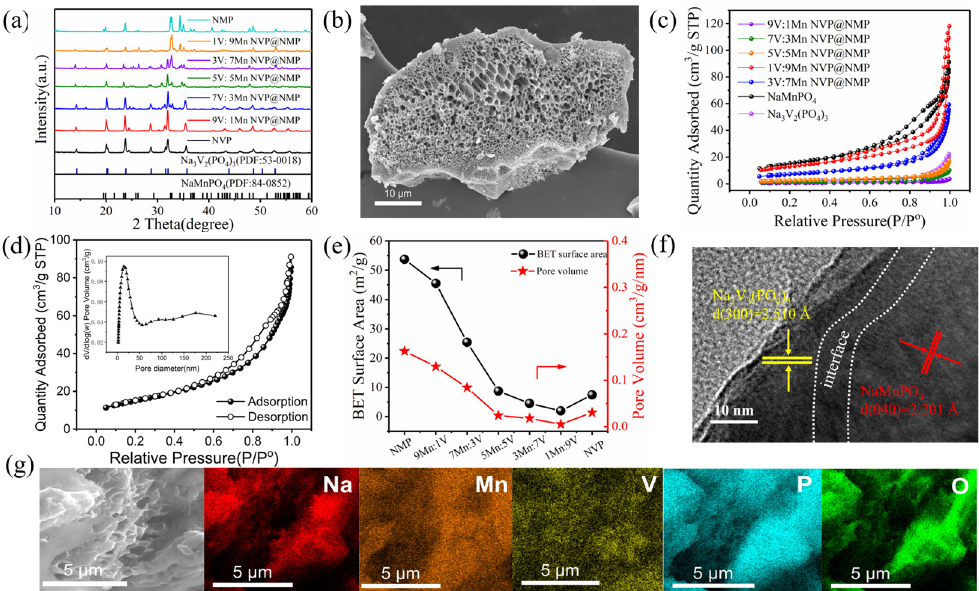
Figure 1. ( a ) XRD patterns of different V: Mn molar ratio adsorbents, ( b ) SEM image of 1V: 9Mn NVMP, ( c ) N 2 adsorption isotherms of different adsorbents, ( d ) N 2 adsorption isotherms of 1V: 9Mn (inset: pore size distribution), ( e ) Relationships among BET surface area, pore volume and different V: Mn molar ratio, ( f) TEM image of 1V: 9Mn NVP@NMP, and ( g ) 1V: 9Mn NVP@NMP corresponding element mapping.